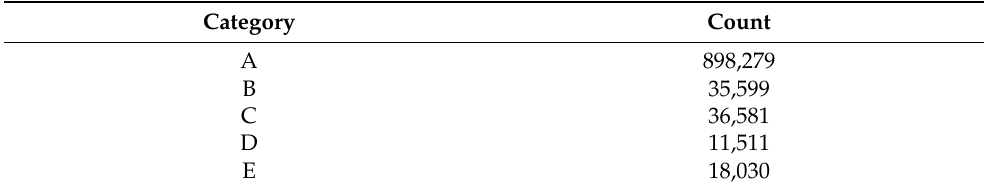
Table 1. Distribution of clients by